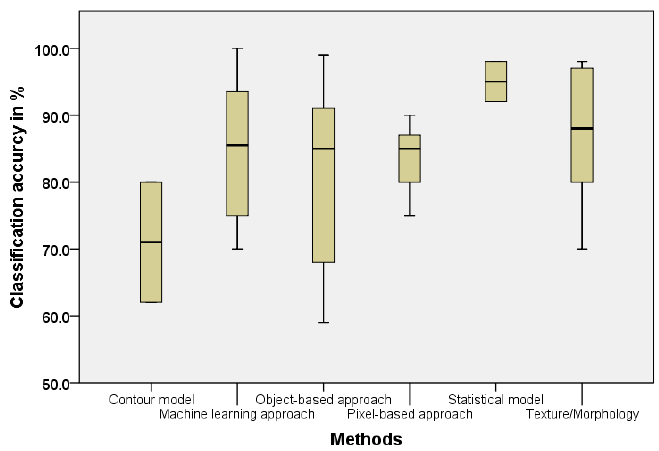
Figure 7. Reported accuracies for different image analysis methods on slum mapping.